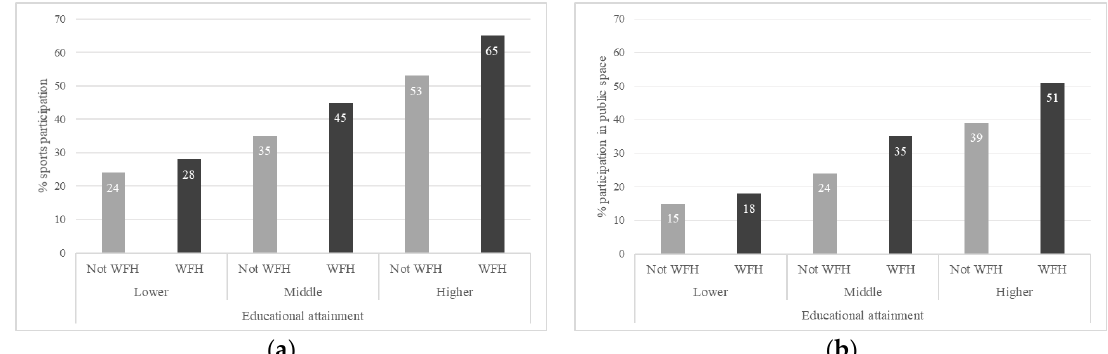
Figure 1. Visualization of the relationship between WFH and sporting behavior, differentiated by educational level for ( a ) sports participation and ( b ) participation in the public space.